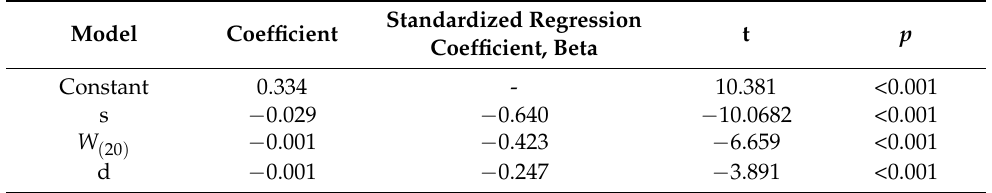
Table 15. Coefficients of the regression model for multi-asperity test.